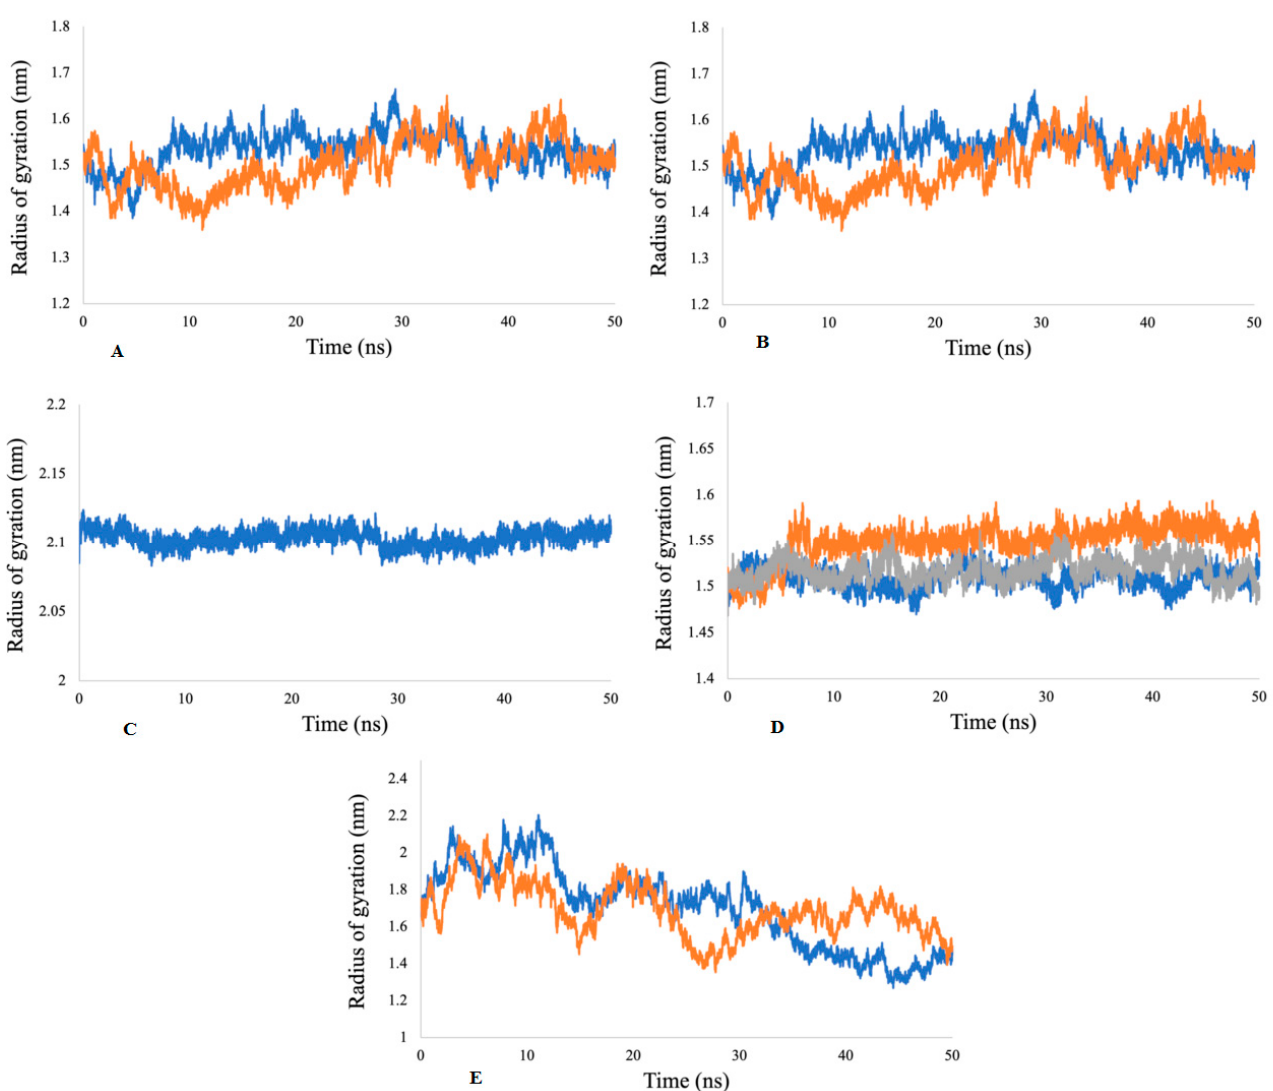
Figure 11. Radii of gyration for ( A ) acetylcholine esterase, ( B ) actin, ( C ) α -tubulin, ( D ) arginine kinase, and ( E ) histone subunit III with inhibitors (disodium 5 ′ -inosinate and petunidin 3-glucoside), (calcium 5 ′ -guanylate D and chlorogenic acid), chlorogenic acid, (kaempferol-3,7-di-O-glucoside I, hyperoside D, delphinidin 3-glucoside ID), and (myricetin 3 ′ -glucoside ID, hyperoside D) complexes.